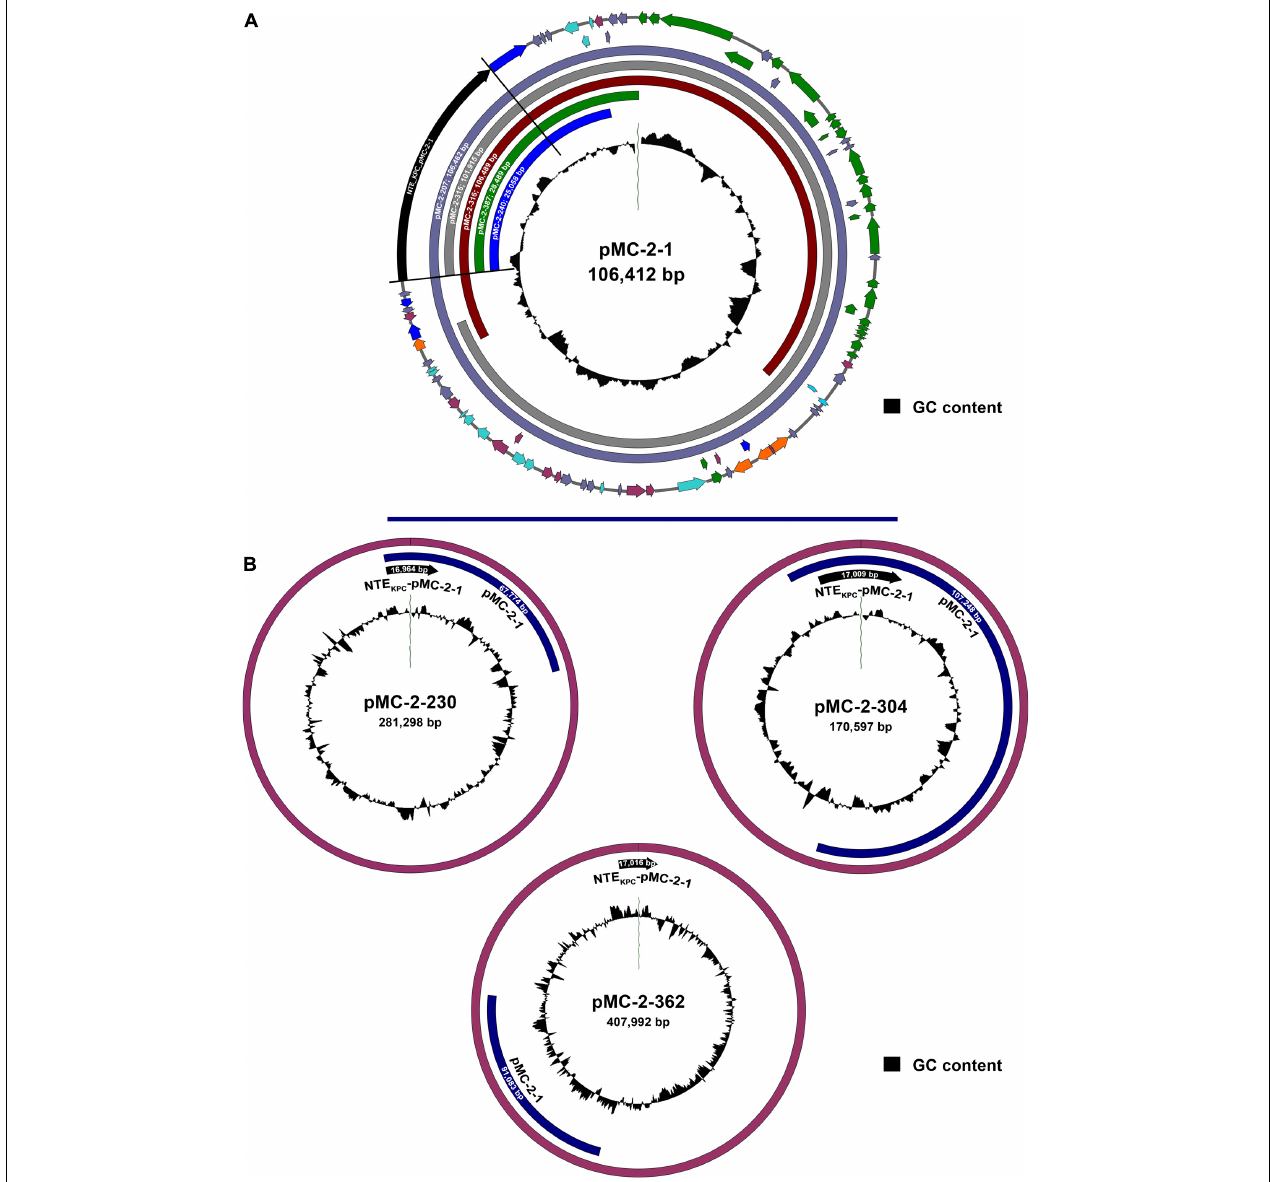
FIGURE 3 | (A) Schematic representation of the 106,412 bp IncFIIk plasmid from the ST15 K. pneumoniae strain MC-2-1 (pMC-2-1) carrying bla KPC - 2 within a NTE KPC -pMC-2-1 genetic structure and sequence alignment with similar IncFIIk plasmid backbones from strains MC-2-207, MC-2-315, MC-2-316, MC-2-387, and MC-2-240 (only the aligned region is shown). Arrows are proportional to the lengths of the genes and oriented in the direction of transcription. Red arrows represent resistance genes, orange arrows represent full-length transposon-related genes and ISs, dark blue arrows represent partial or truncated transposon-related genes and ISs, green arrows indicate genes involved in plasmid conjugation and light blue arrows shown genes related to plasmid replication/maintenance. Blue-gray arrows show putative or hypothetical genes and plum arrows show genes involved in other functions. The inner circle shows the GC content. The fully annotated sequence of plasmid pMC-2-1 is shown in Supplementary Figure 3 . (B) Schematic representation of the larger IncFIIk plasmids carrying bla KPC - 2 recovered from strains MC-2-230, MC-2-304, and MC-2-363. The location of the genetic structure NTE KPC -pMC-2-1 harboring bla KPC - 2 is shown as well as the region matching the pMC-2-1 sequence. The inner circle shows the GC